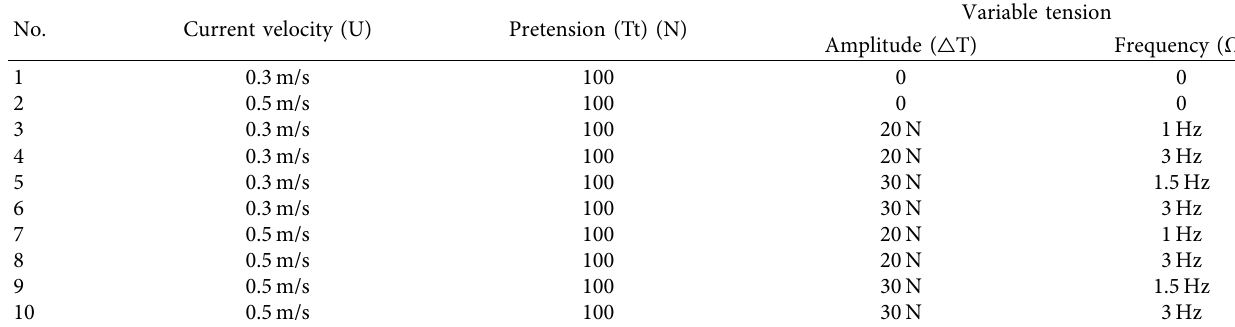
Table 5: Test conditions.